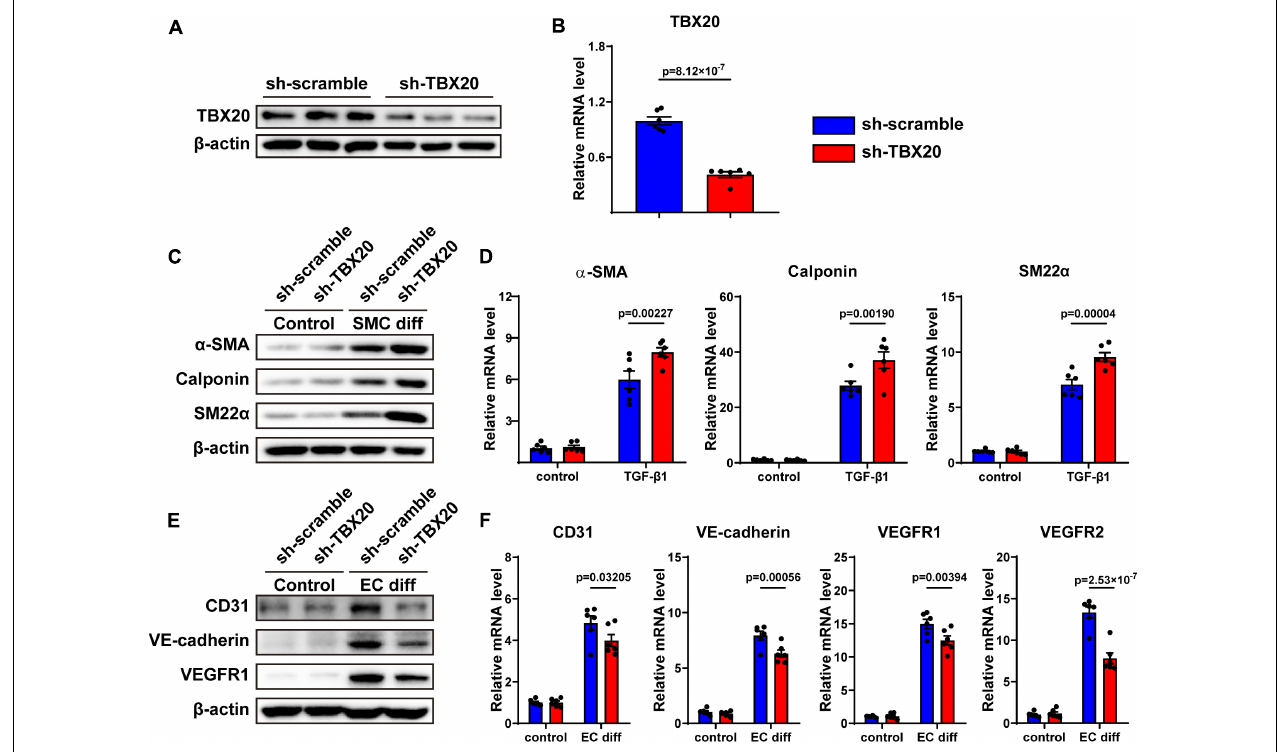
FIGURE 3 | Knockdown of TBX20 improved SMC differentiation and inhibited EC differentiation. (A,B) TBX20 level was significantly downregulated after shRNA TBX20 transfection, determined with Western Blot (A) and QPCR (B) . (C,D) Transfection of PVASCs with sh-TBX20 lentivirus improved the level of SMC markers as shown by Western Blot (C) and QPCR (D) . (E,F) Transfection of PVASCs with sh-TBX20 lentivirus inhibited the level of EC markers as shown by Western Blot (E) and QPCR (F)